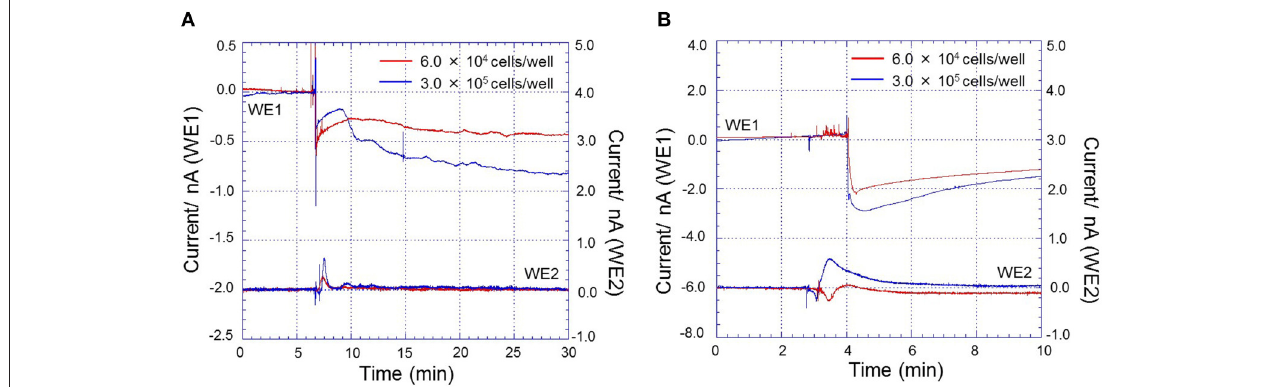
FIGURE 10 | Real-time monitoring of oxygen reduction current and reduction current for H 2 O 2 during respiratory burst in THP-1 cells (A) and HL-60 cells (B) under the effect of 200 nM PMA at a constant temperature of 30 ± 0.5 ◦ C and density of 6.0 × 10 4 cells/well (red trace) and 3.0 × 10 5 cells/well (blue trace) using a chip-type biosensor device. Changes in oxygen reduction current was measured using Pt microelectrode, WE1 while changes in reduction current for